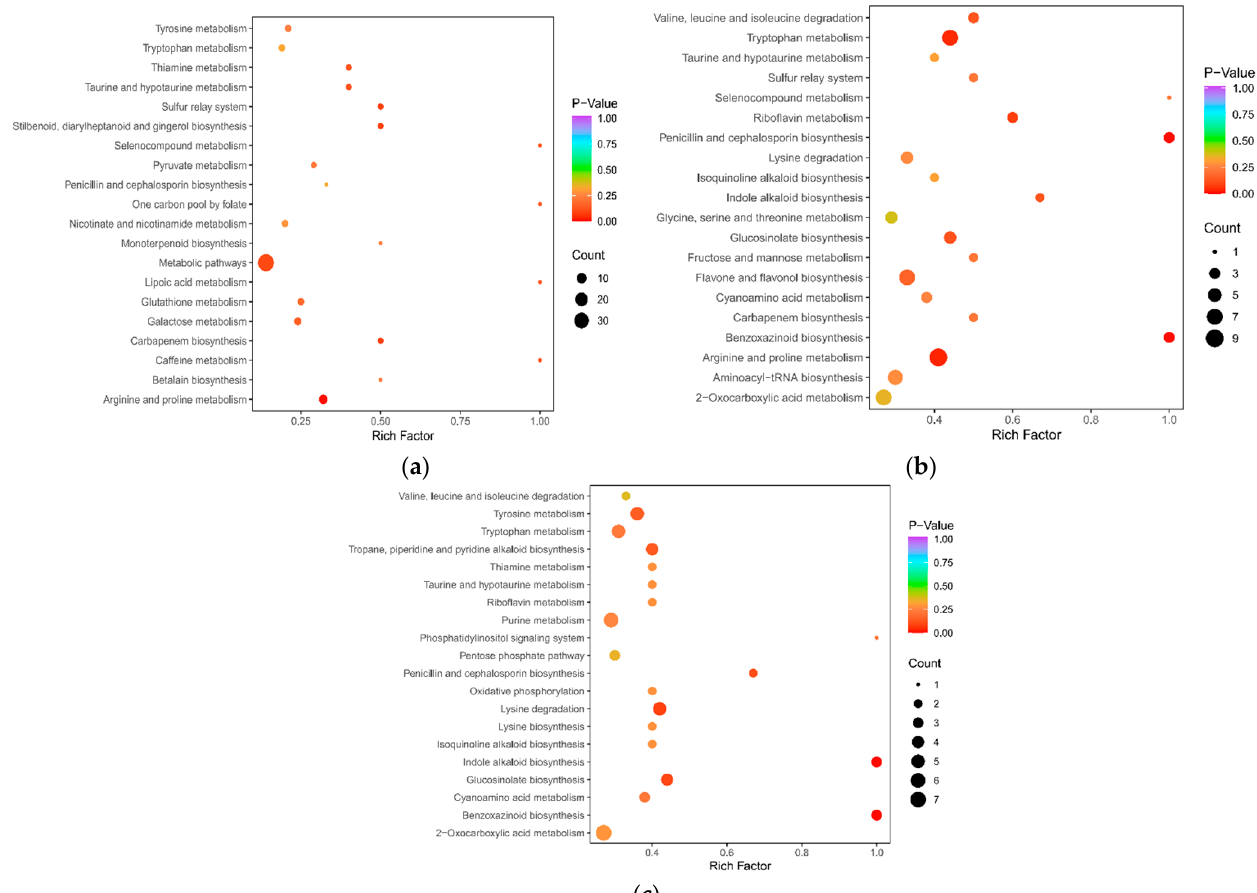
Figure 3. KEGG enrichment bubble. ( a ) L-K vs. L-G. ( b ) N-G vs. L-G. ( c ) N-K vs. L-K. The abscissa represents the Rich Factor corresponding to each pathway, and the ordinate represents the pathway name. The color of points reflects the p -value size, and the redder indicates the more significant enrichment. The size of the dot represents the number of enriched differential